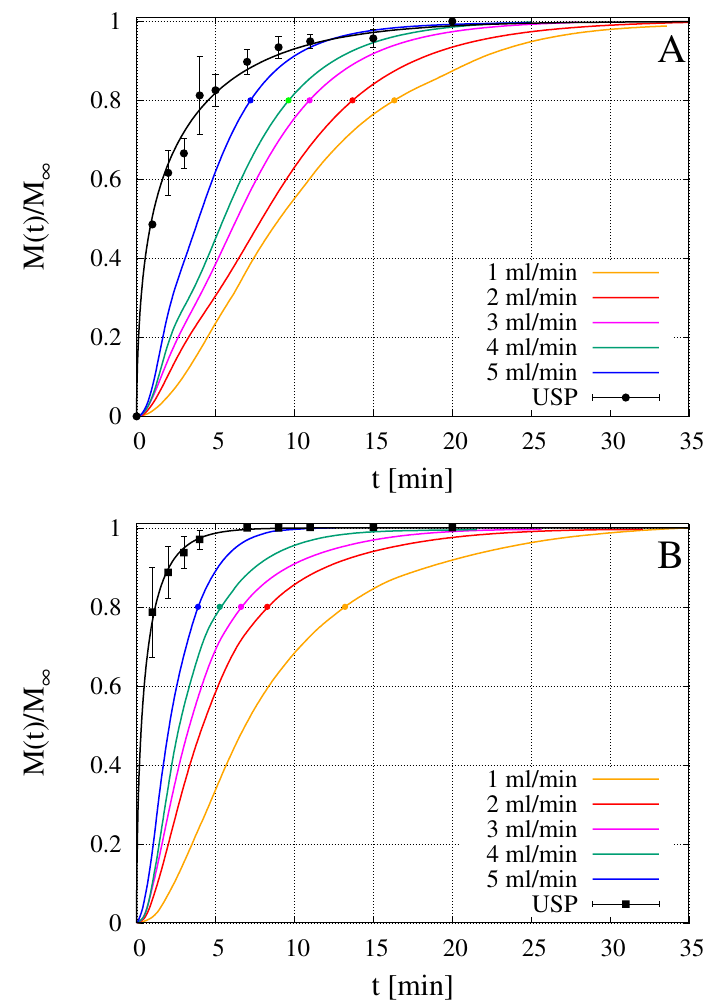
Figure 8. Rescaled integral release curves M ( t ) / M ∞ vs. time t [min] of fluconazole in millifluidic flow-through device (MFTD) and USP II device. ( A ) GG-2%Gly films loaded with the preformed inclusion complex Flu/HP- β -CD; ( B ) GG-6%Gly films loaded with not complexed